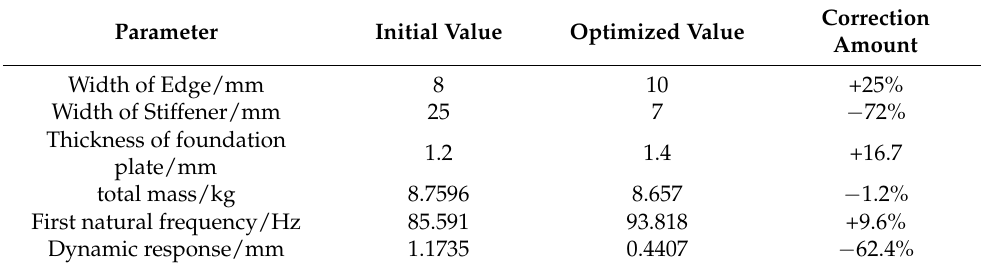
Table 5. Results of structural